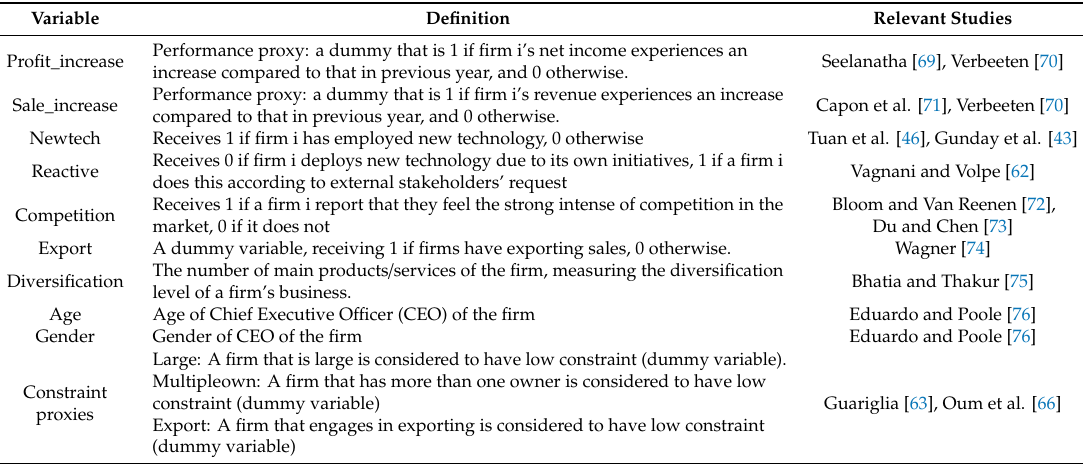
Table 1. Variable